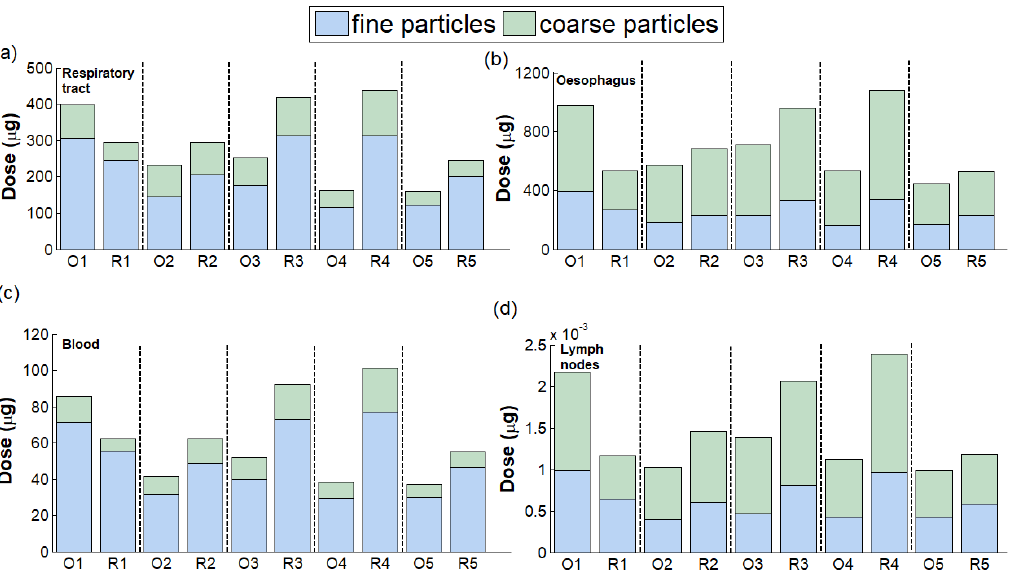
Figure 3. Weekly (5 days) dose of fine (PM 2.5 ) and coarse (PM 2.5–10 ) particles in the ( a ) respiratory tract (retained dose), ( b ) GI-tract (Oesophagus), ( c ) blood, and ( d ) Lymph nodes. O1–O5: outdoor exposure scenario, R1–R5: realistic exposure scenario.